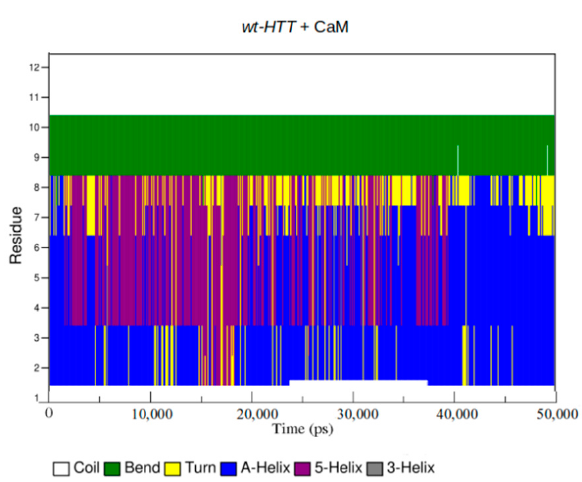
Figure 10. DSSP plots for secondary structure transitions between residue numbers 4 and 12 for the wt ‐ HTT model.